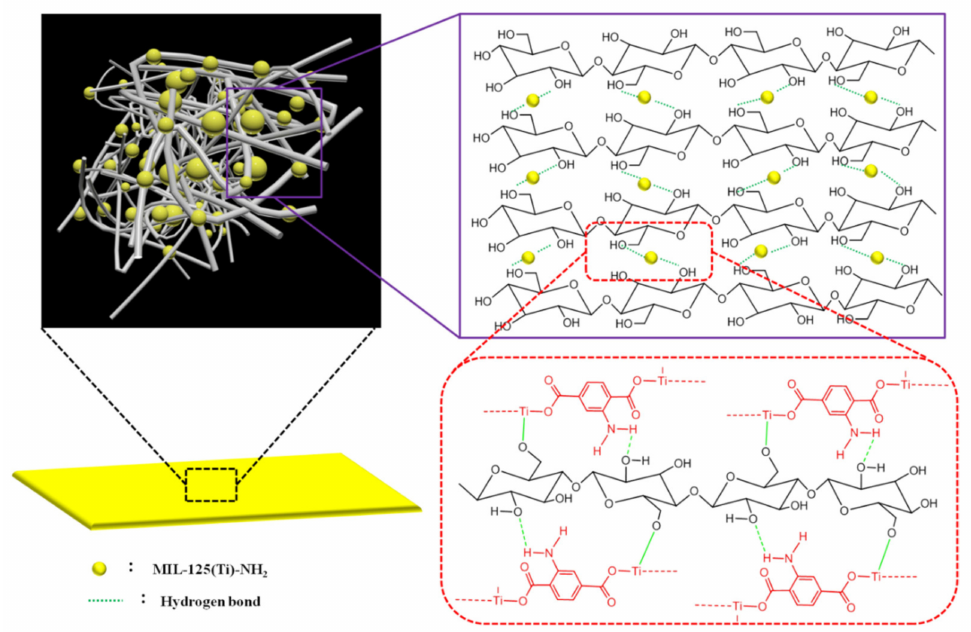
Figure 5. Schematic of the intermolecular hydrogen bonding between cellulose and MNPs in